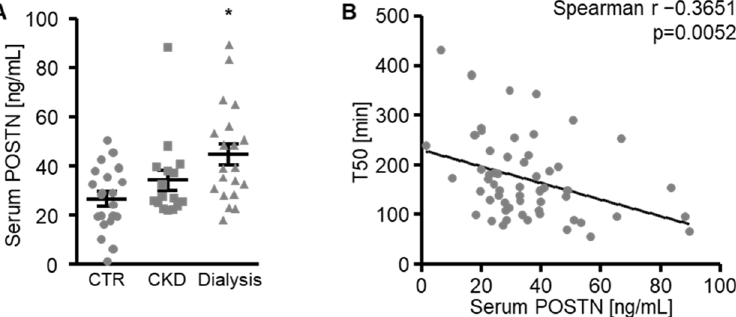
Figure 8. Serum periostin levels are increased in hemodialysis patients. ( A ) Serum periostin (POSTN) levels in healthy volunteers (CTR), patients with known CKD (CKD) and hemodialysis patients (Dialysis). * p < 0.05 (significant difference versus CTR group). ( B ) Correlation between serum periostin (POSTN) concentrations and serum calcification propensity measured as calciprotein particle maturation time (T50). The p -value is indicated in the figure.